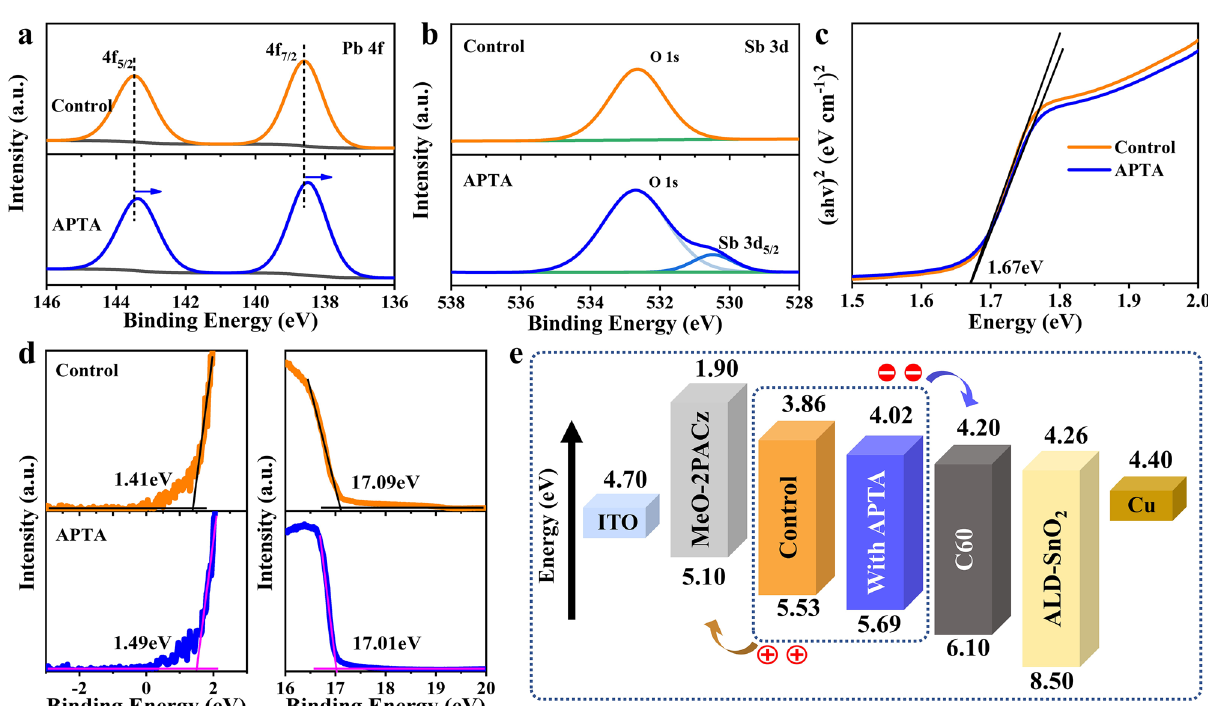
Fig. 4 a Pb 4 f and b Sb 3 d XPS spectra for perovskite films without and with APTA. c Tauc plot and the corresponding optical bandgaps of per- ovskite films. d UPS spectra in the secondary electron cut-off and Fermi energy cut-off regions of the perovskite films. e Energy-level diagram for the inverted PSC device structure of ITO/MeO-2PACz/perovskite/C 60 /ALD-SnO 2